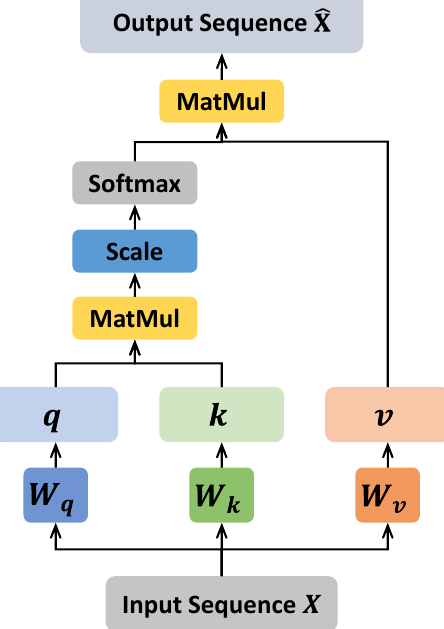
Figure 2. The calculation process of self-attention